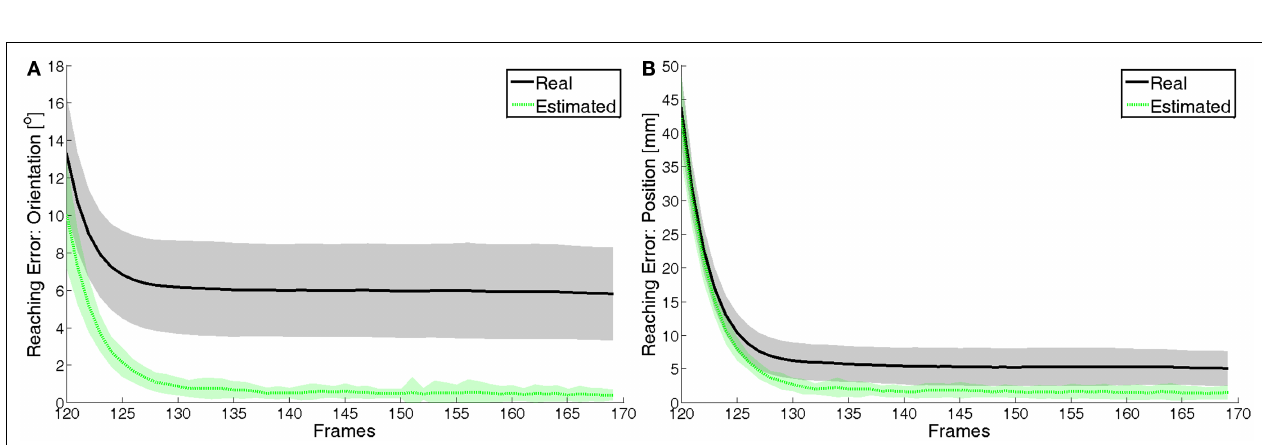
FIGURE 8 | Real and estimated reaching error in the closed-loop phase: (A) orientation and (B) position . In black (solid), we can see the real reaching error and, in green (dotted), we can see the estimated reaching error. The latter converges to 0 as expected, proving that the closed-loop control is working properly.